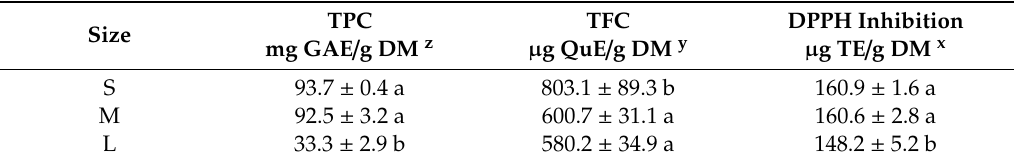
Table 2. Phytochemical characteristics of the avocado peel extract from small (S), medium (M), and large (L) fruit